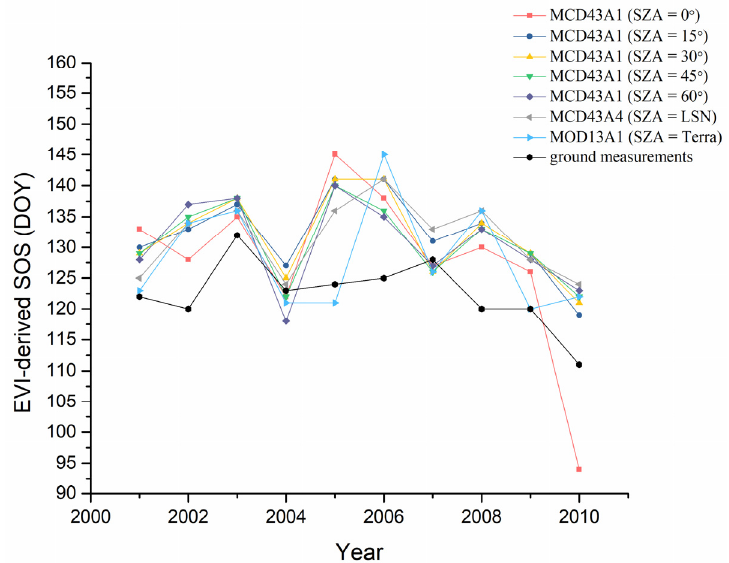
Figure 4. SOS derived from the EVI time series from 2001 to 2010. SZA = 0°, 15°, 30°, 45° and 60° denote the SOSs derived from the MCD43A1 (BRDF) product with a consistent angle configuration; SZA = LSN and SZA = Terra refer to SOSs derived from the MCD43A4 (NBAR) product and the MOD13A1 (VI) product, respectively.